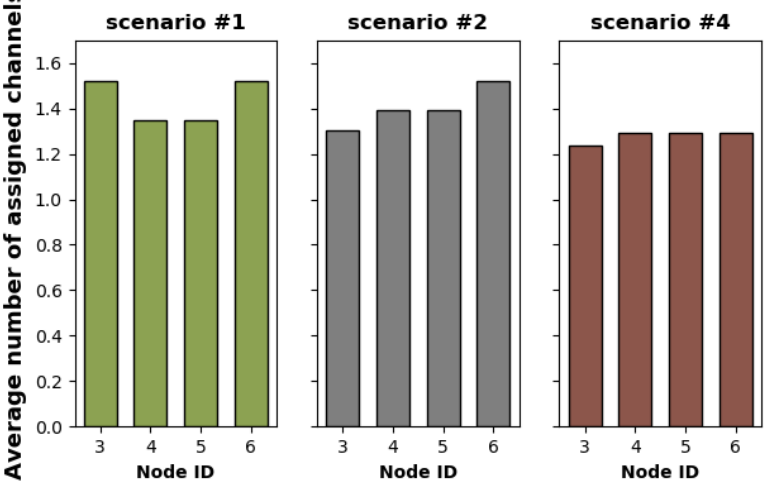
Figure 8. Average number of assigned channels per secondary